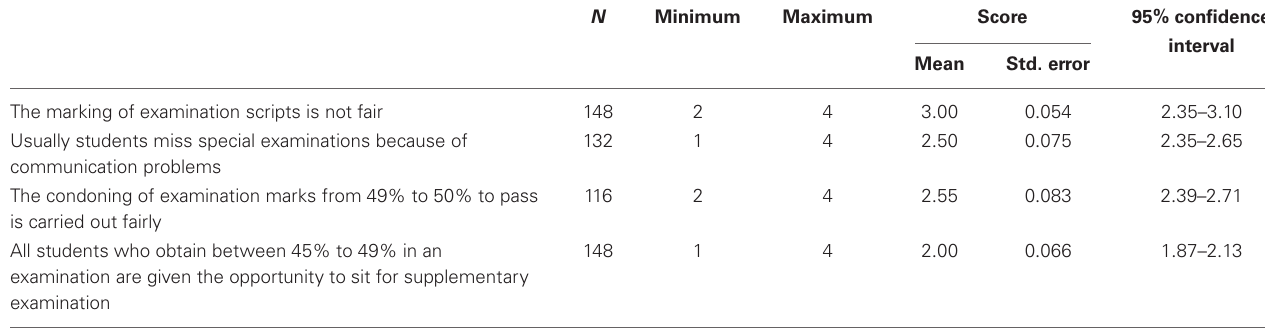
Table 8 | Expressed views on the fairness in the conduct of examination at the University of Namibia. N Minimum Maximum